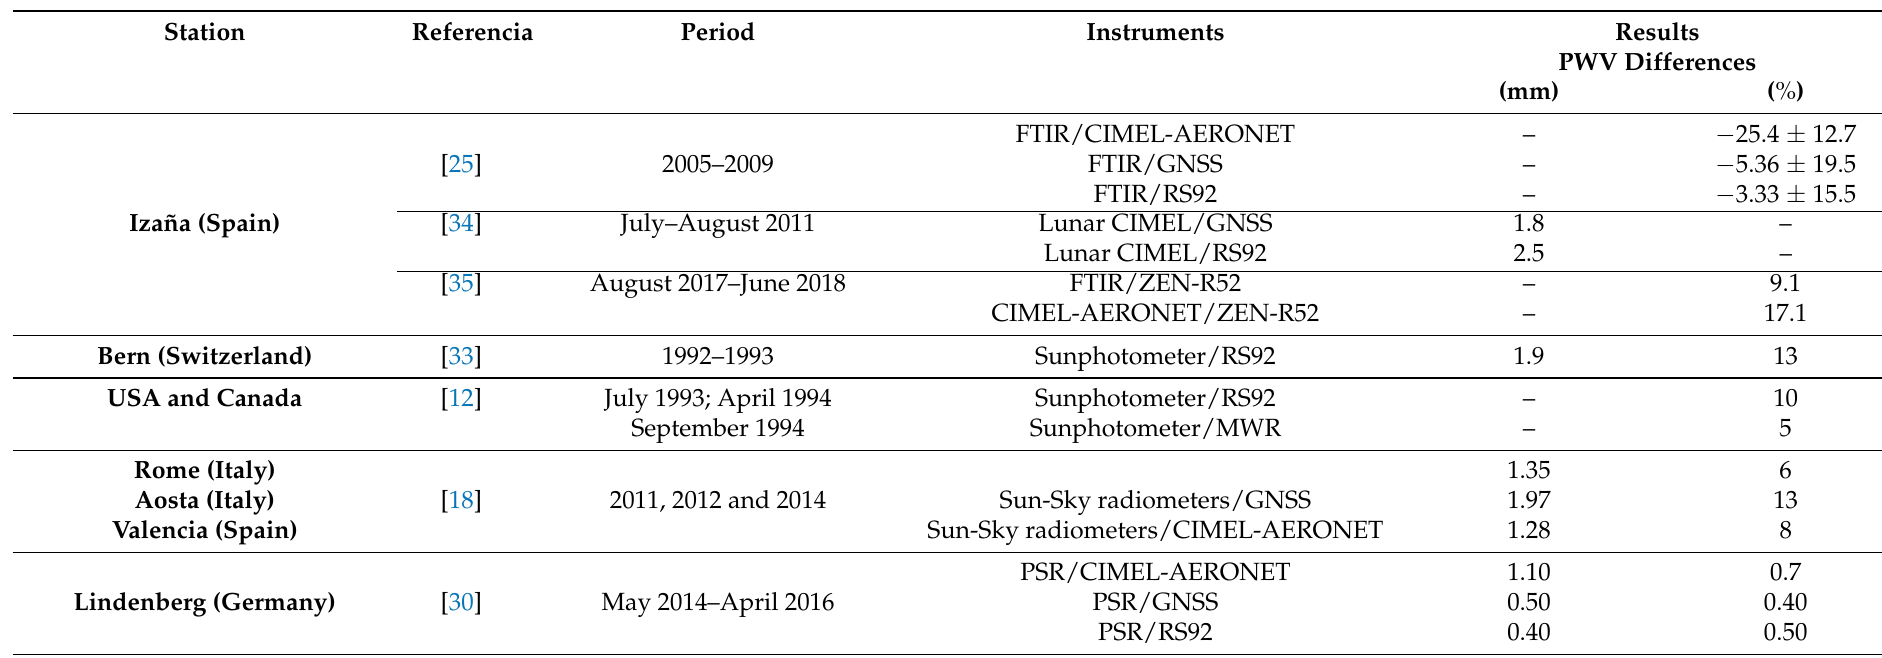
Table 3. Summary of comparisons of PWV between different techniques performed by others authors. (MWR: Microwave Radiometer; PSR: Precision Solar Spectroradiometer).